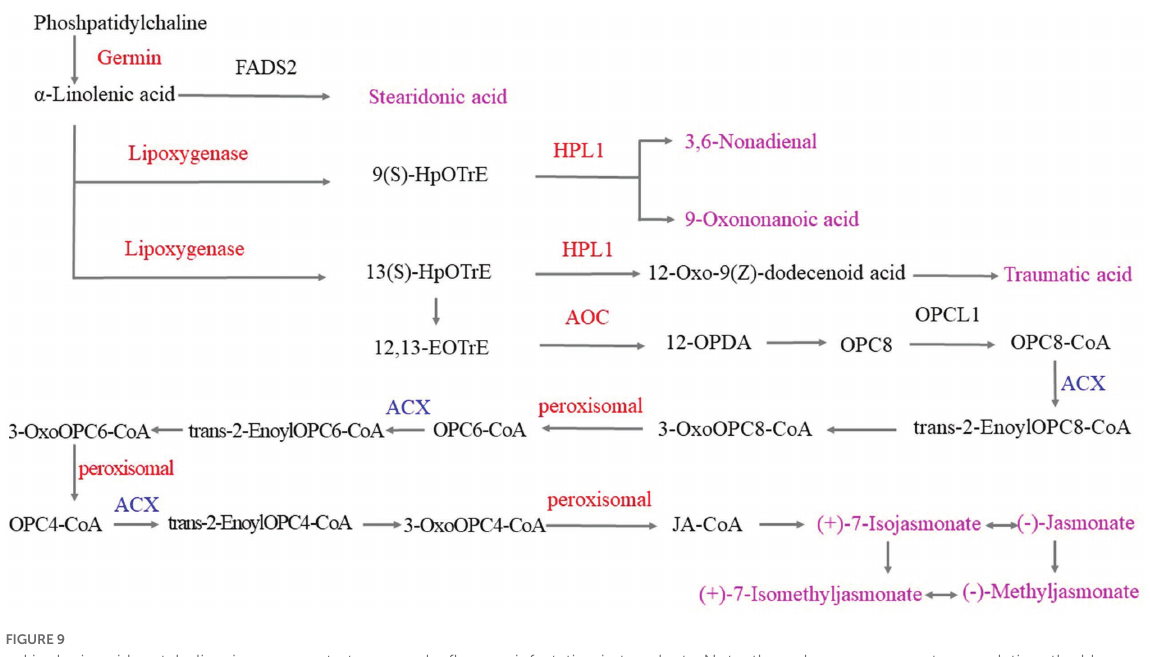
α -Linolenic acid metabolism in response to tea green leafhopper infestation in tea plants. Note: the red genes represent upregulation; the blue genes represent downregulation, and the pink metabolites were obtained in response to tea green leafhopper